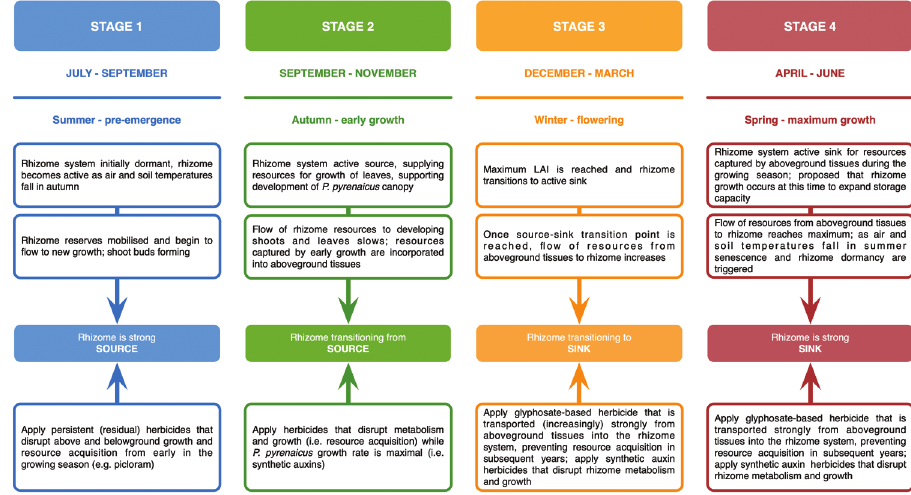
Figure 2. Conceptual four stage mechanistic model of phenological changes in P. pyrenaicus growth, resource allocation and rhizome source-sink strength during the temperate northern hemisphere growing season (adapted from Jones et al. 2018). LAI = leaf area index. Note linkage of above and belowground growth processes with changes in source-sink strength and that rhizome tissue sink strength increases through the winter from November, reaching a peak in April-June during